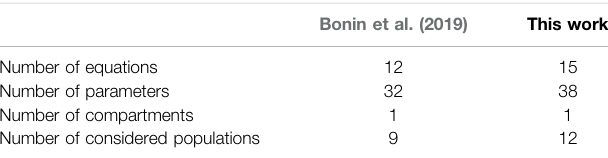
TABLE 1 | Major differences between the models proposed in a previous work (Bonin et al., 2019) and in this work.